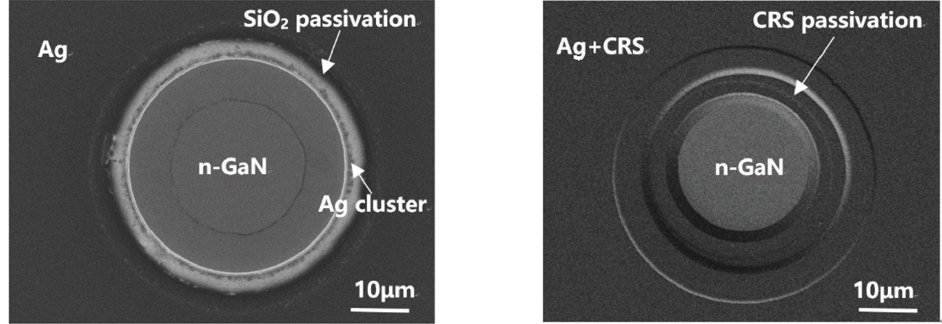
Figure 7. SEM top view of FCLED after forward current aging with ( a ) SiO 2 passivation layer; ( b ) CRS passivation